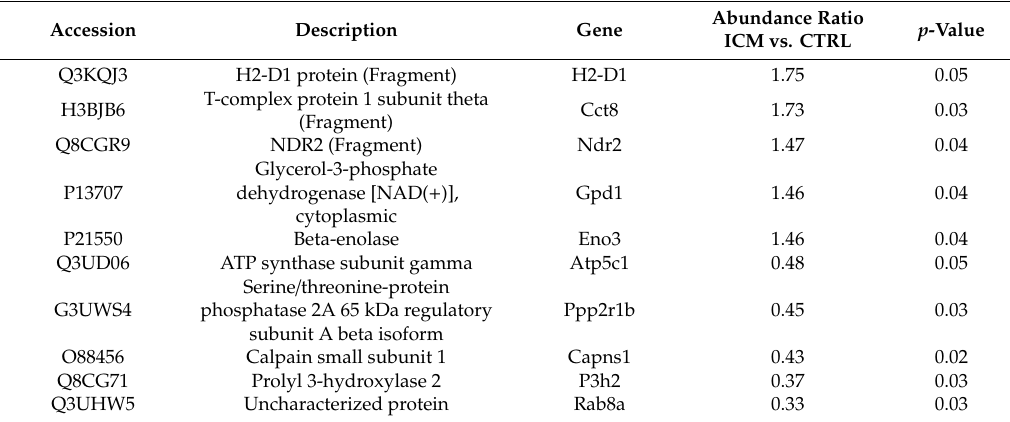
Table 2. Top 10 list of the most induced and most inhibited proteins in ICM vs.